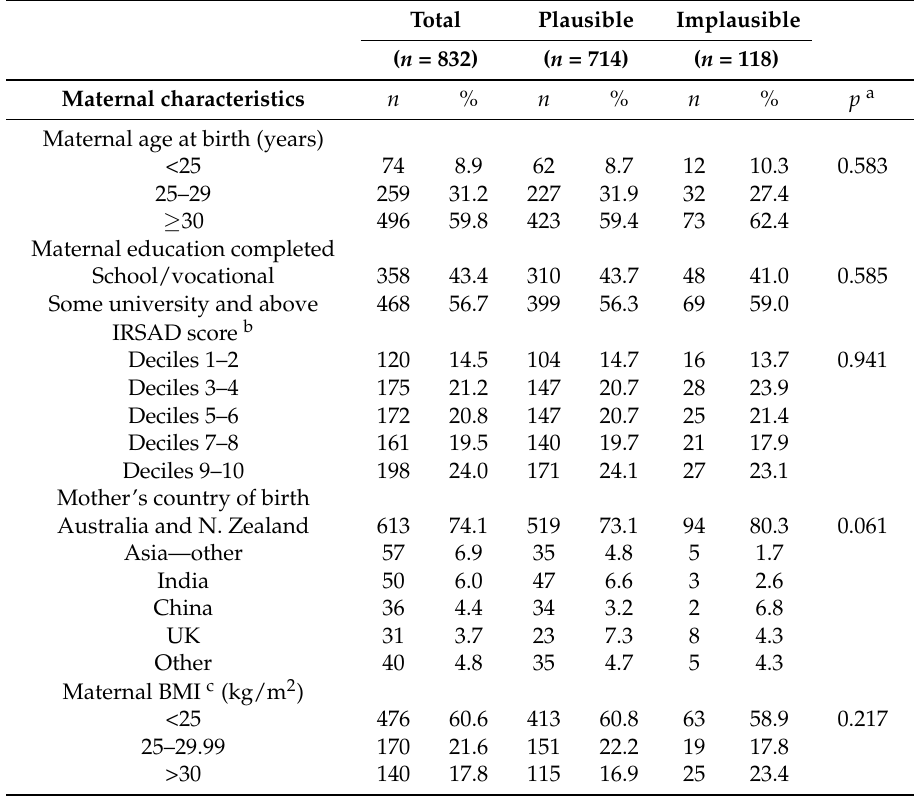
Table 1. Characteristics of mother–child dyads with complete dietary data and of the subsets with plausible and implausible energy